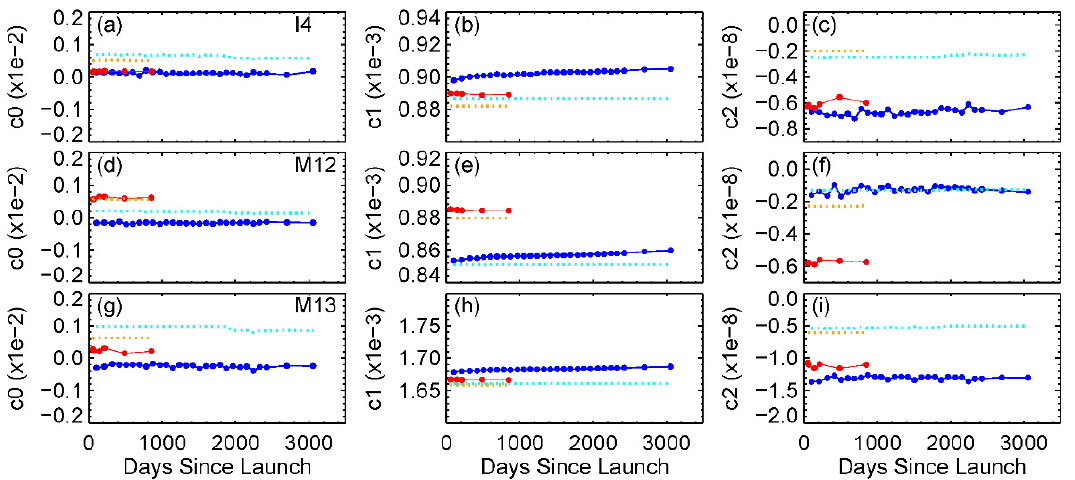
Figure 8. Comparison of WUCD derived MWIR band-averaged C-coefficients ( c 0 , c 1 and c 2 ) for NOAA-20 (red) and S-NPP (blue): ( a – c ) I4, ( d – f ) M12, and ( g – i ) M13. Prelaunch C-coefficients are also shown in dash lines (NOAA-20: orange color; S-NPP: cyan color). 4. Evaluation of NOAA-20 and S-NPP VIIRS TEB Sensor Data Records (SDR) Perfor- mances